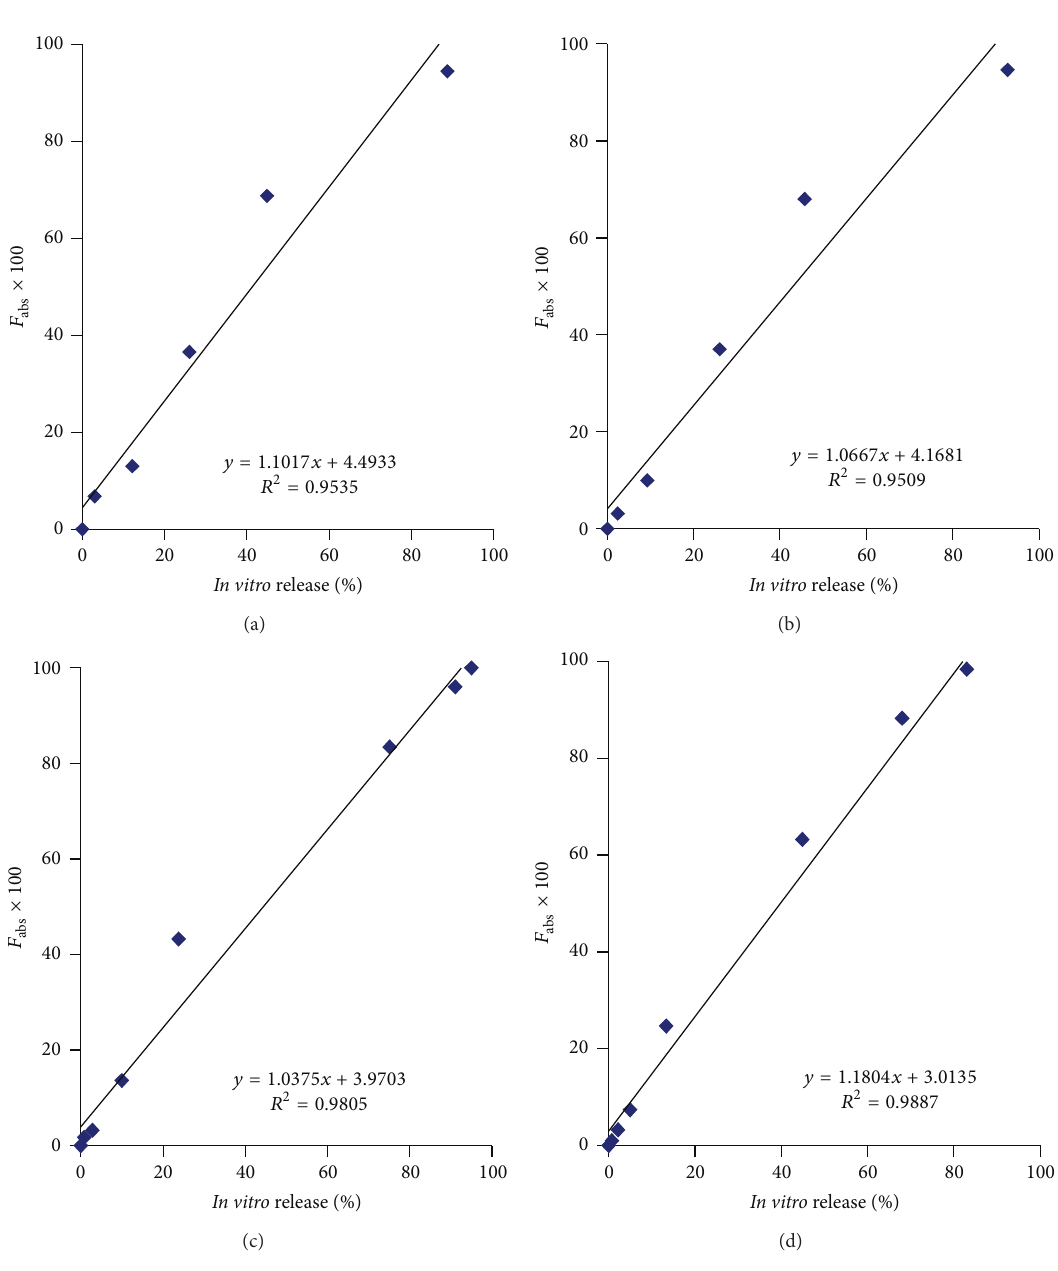
Figure 7: Level A IVIVC for Olanzapine PLGA microspheres using Nelson-Wagner